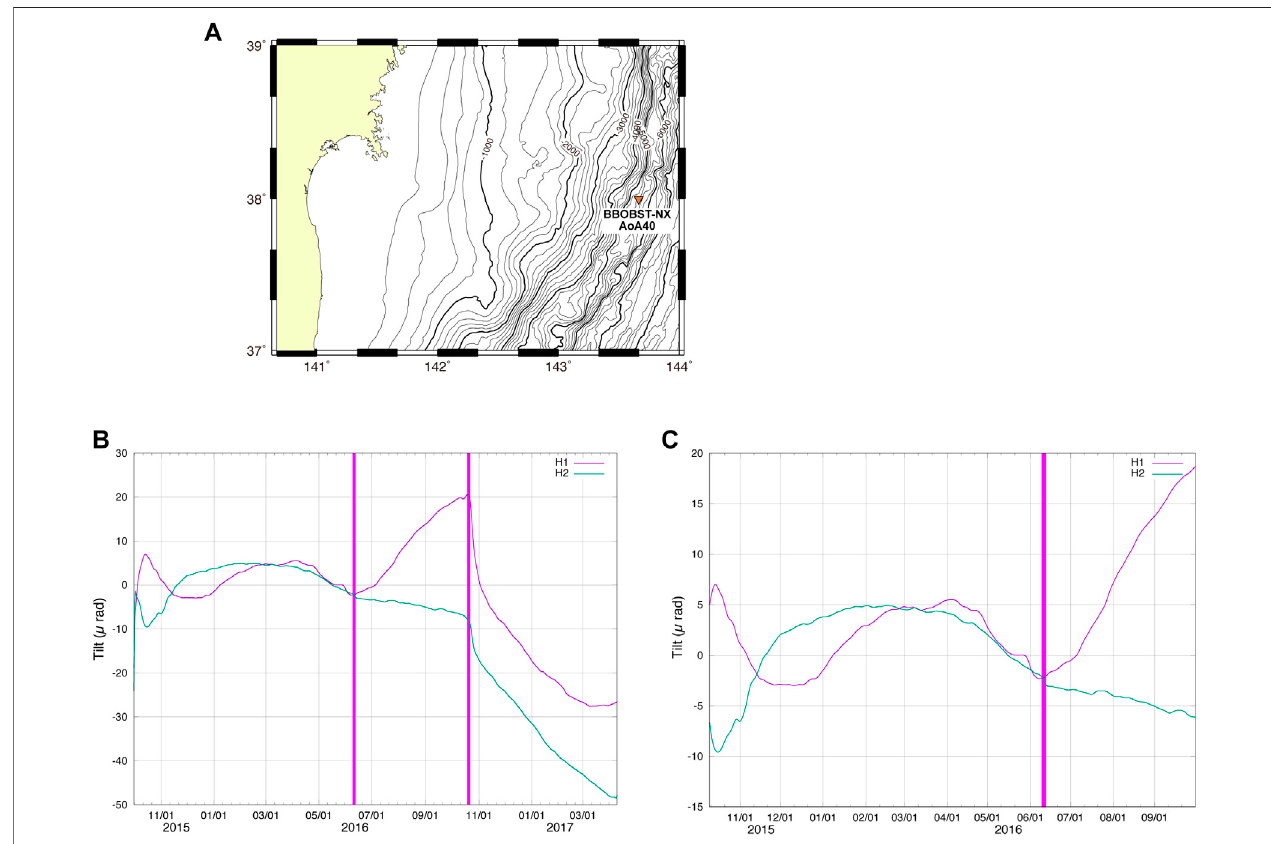
FIGURE 8 | The long-term test off the Miyagi Prefecture. For more detail validation of the BBOBST-NX, a test lasting more than 1 years was conducted at the landwardterrace neartheJapantrench. (A) Thelocationmapofthesite,AoA40,5,430 mdepth.Nobottomcurrentobservationwasconducted inthistime. (B) Results of whole observation period of 18 months (earlier recovery due to the ship schedule). The data processing was the same as in Figure 7C. The H1 component had a similar direction matched with the maximum gradient (6 ° ) of the sea fl oor. Two thick purple lines show the starting points of the large tilt change mentioned in Feasibility Observations (C) Same as (B) but re-scaled in both axes as in Figure 7C for easier comparison.